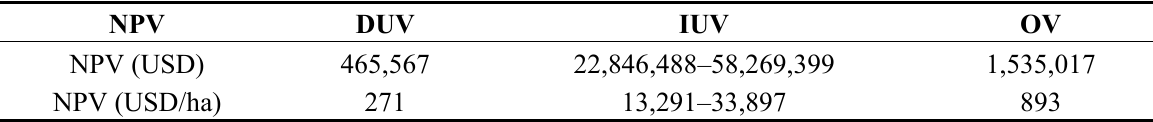
Table 5. The Net Present Value (NPV) of mangrove in the Takalar district, South Sulawesi,